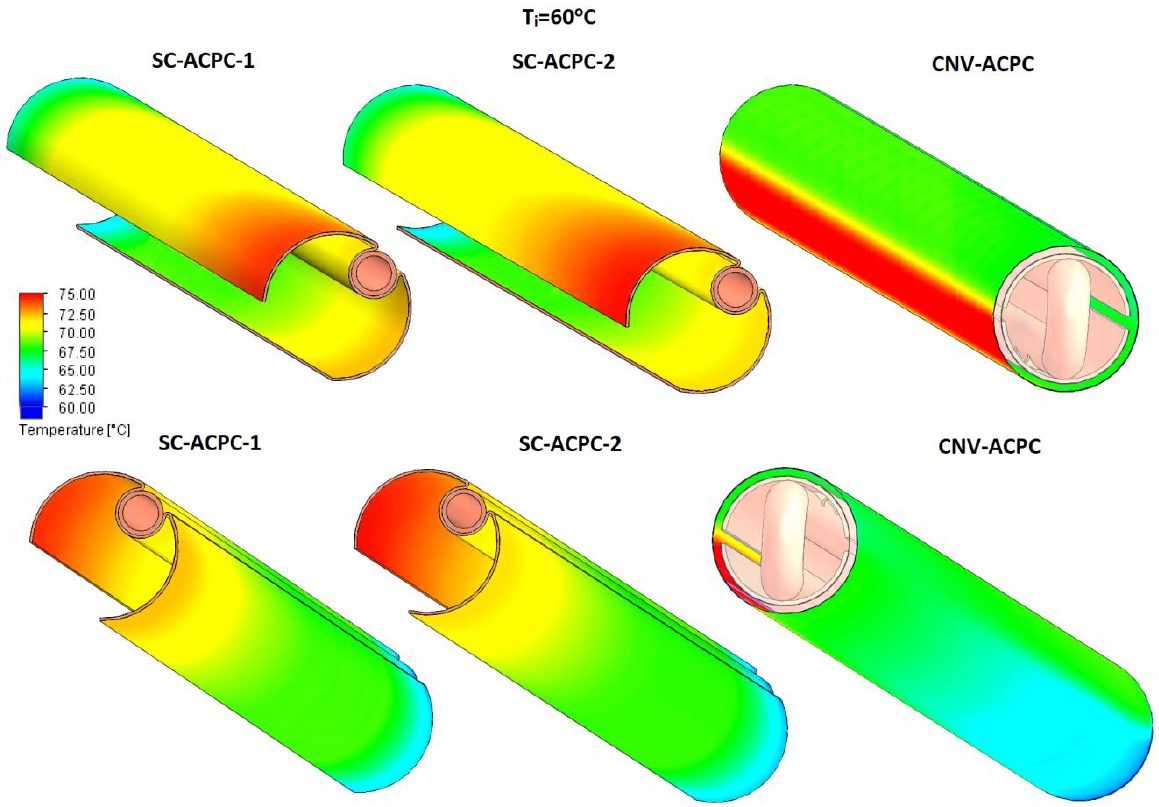
Figure 11. Receiver surface temperature distribution in each ACPC.